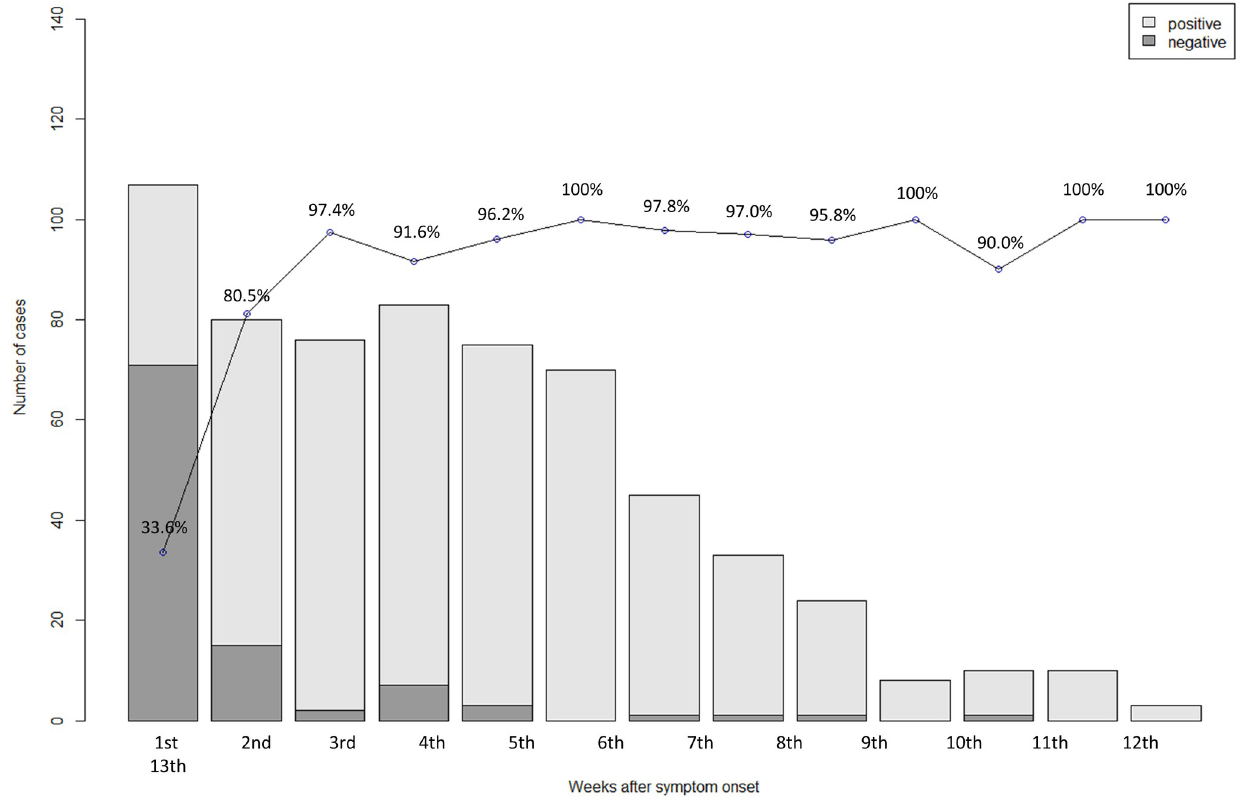
Fig 1. Anti-SARS-CoV-2 antibody positivity rate over time after symptom onset. Numbers above bars are positivity rates.